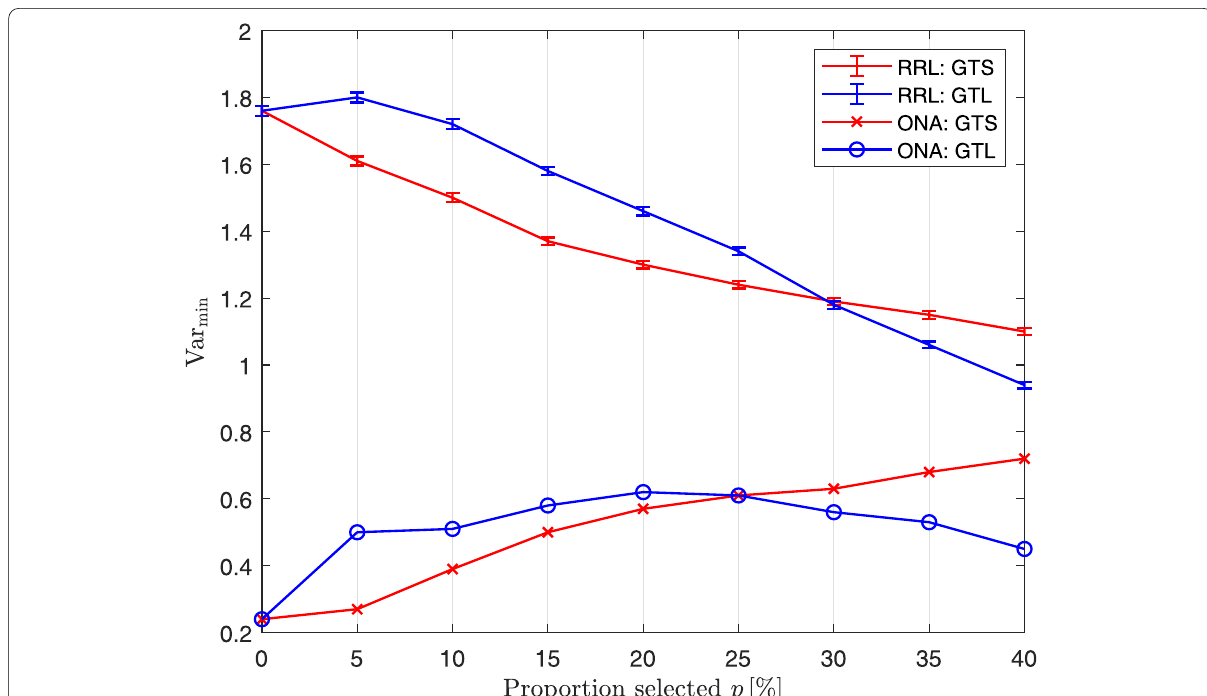
Fig. 1 The Var min criterion (Y-axis) of the seed orchard layout following the genetic thinning, with 0–40% ramets removed from the orchard (X-axis). Genetic thinning was applied to either the randomized seed orchard scheme (“random reference line, RRL”; averages of 100 stochastic iterations) or the declared ONA scheme (“ONA”; optimum layout). Both GTS and GTL deployment options are shown in the